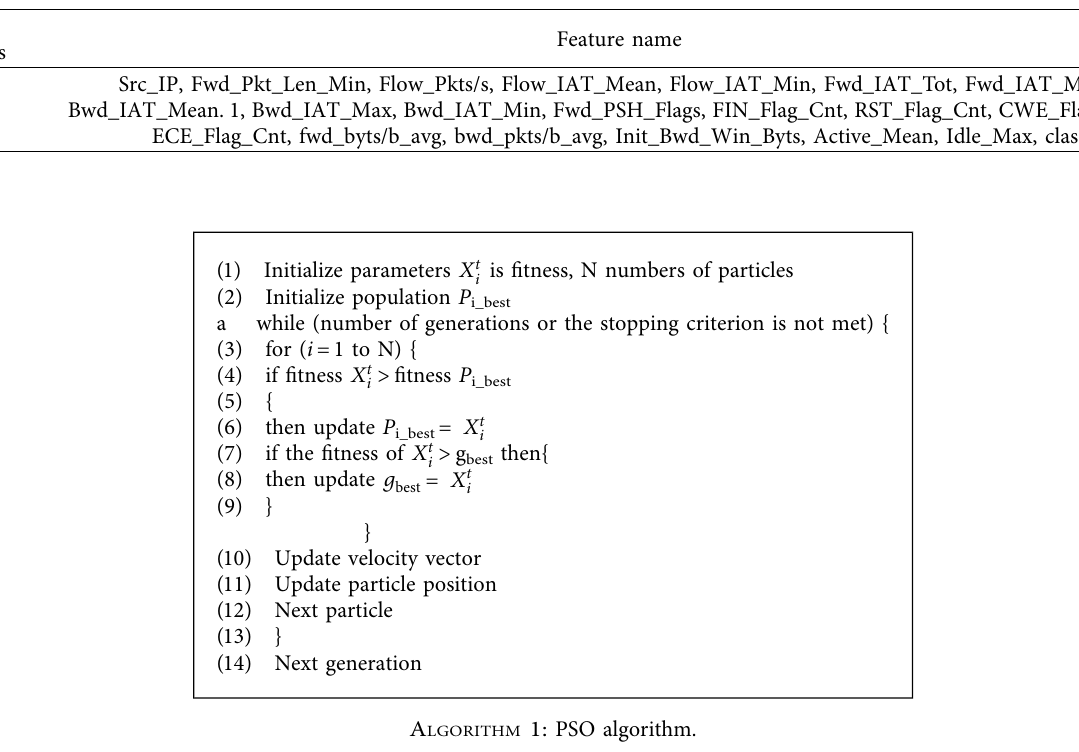
Figure 5: Particle swarm optimization algorithm steps for selecting subsets. Table 2: 21 significant features obtained by using the PSO